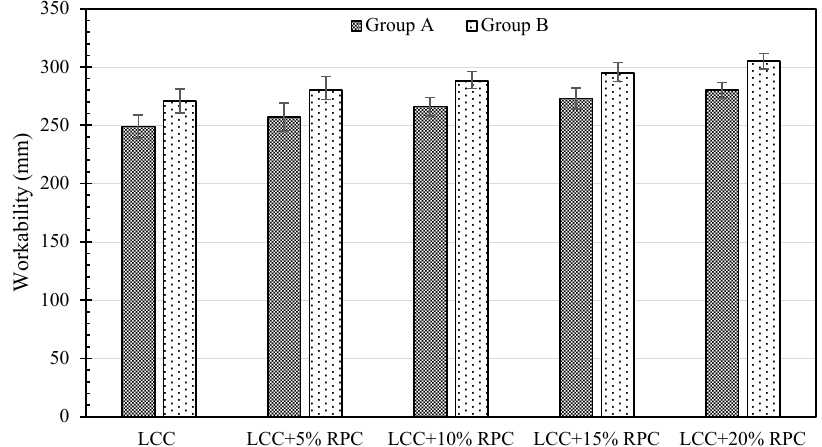
Figure 3. Workability of two groups of concretes containing various amounts of RPC.